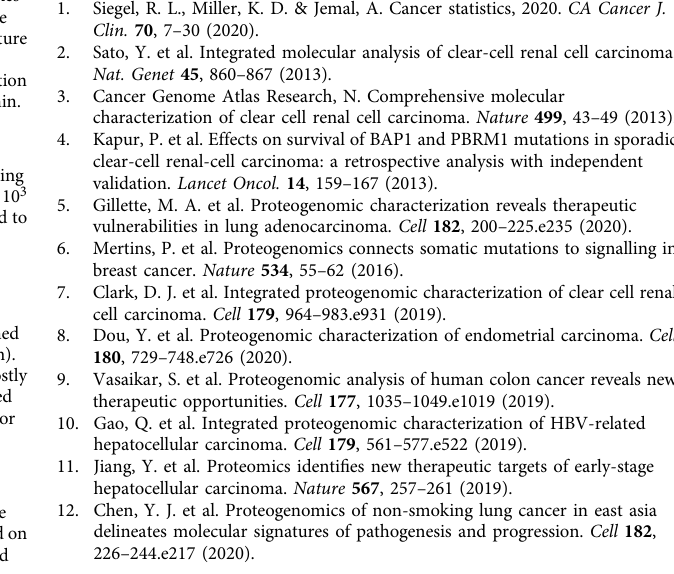
Figshare (https://doi.org/10.6084/m9. fi gshare.17206589). TCGA ccRCC data were downloaded from Xena (https://xenabrowser.net/). CPTAC ccRCC could be accessed